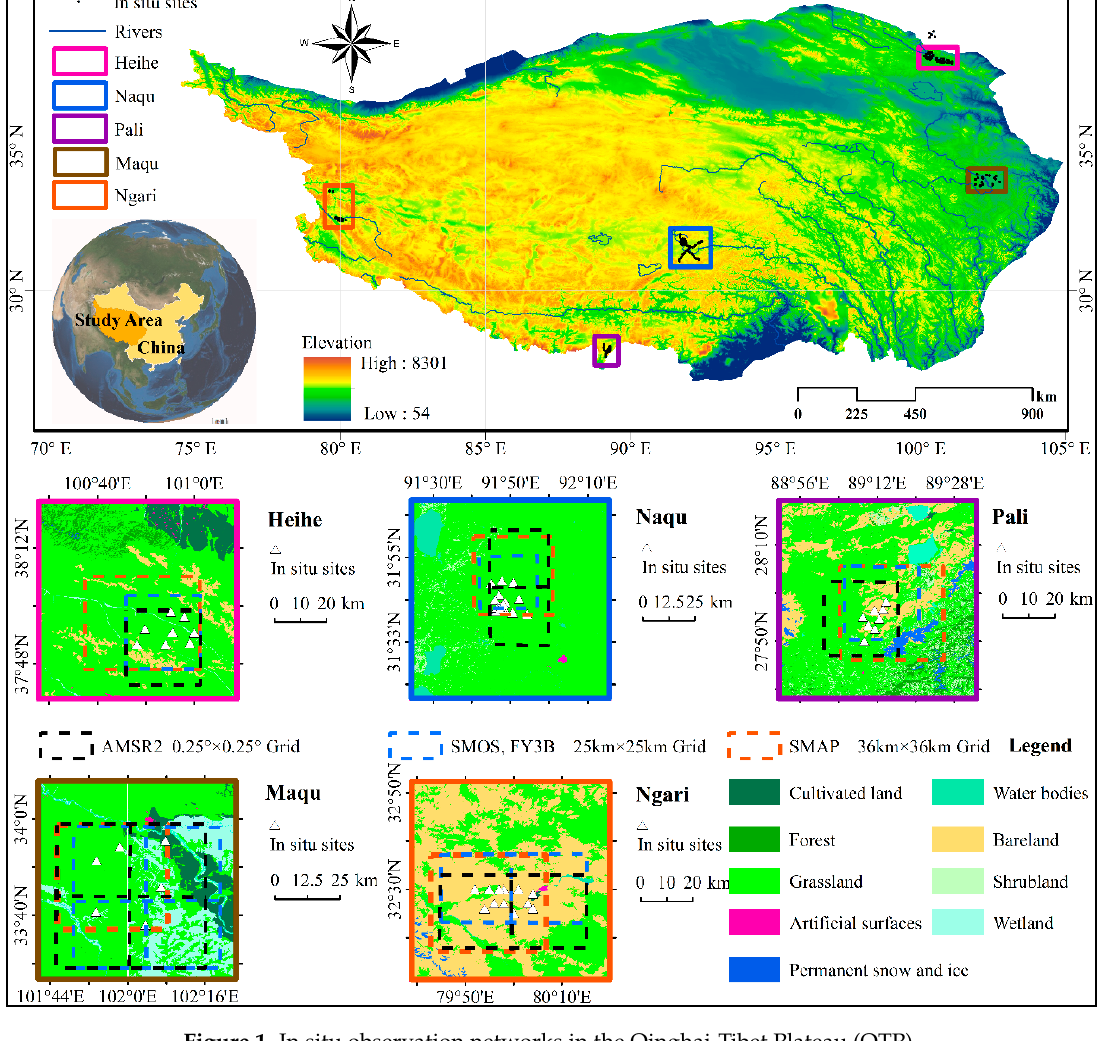
Figure 1. In situ observation networks in the Qinghai-Tibet Plateau (QTP) .